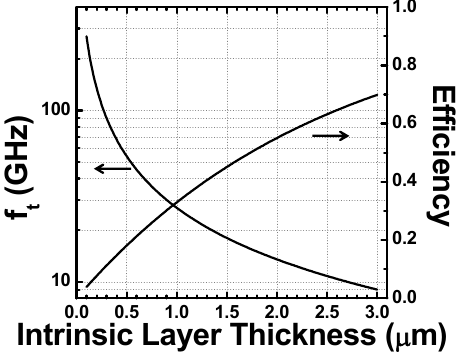
Figure 3. A Calculated carrier-transit-time-limiting bandwidth and efficiencies of normal incidence PIN Ge